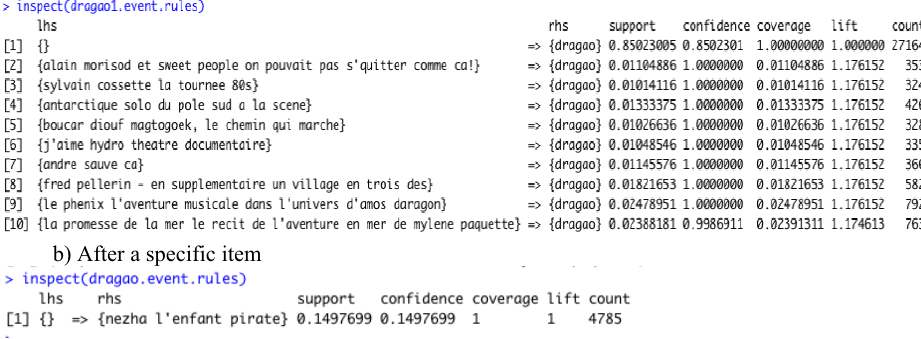
Fig. 4. Specific knowledge as